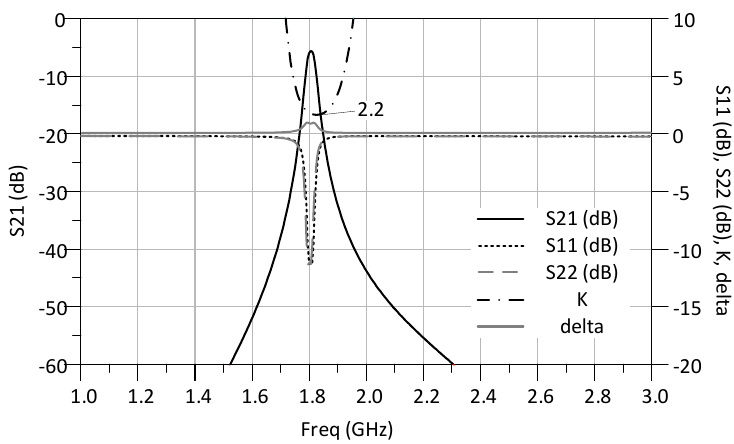
Figure 7. Simulated S-parameters and stability parameters of the two-cell filter for a single frequency.